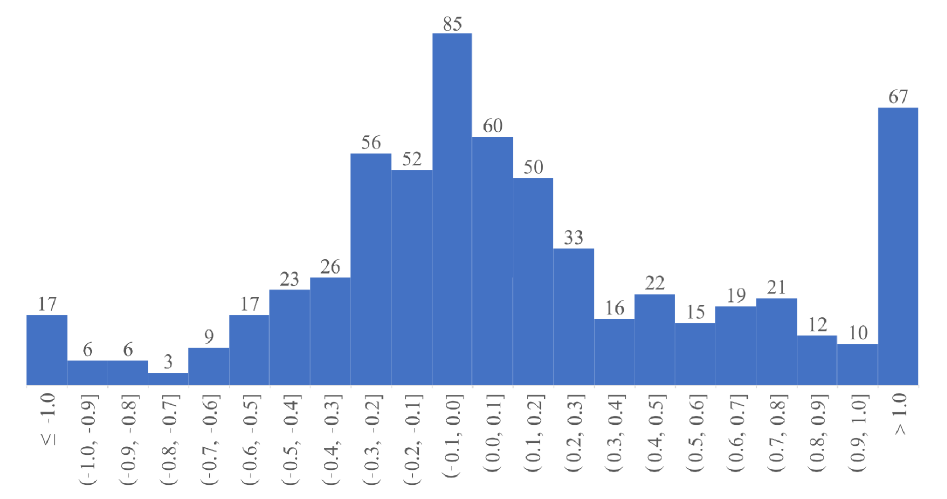
Figure 14. Histogram of the number of occurrences of the error values [m] for the TIN